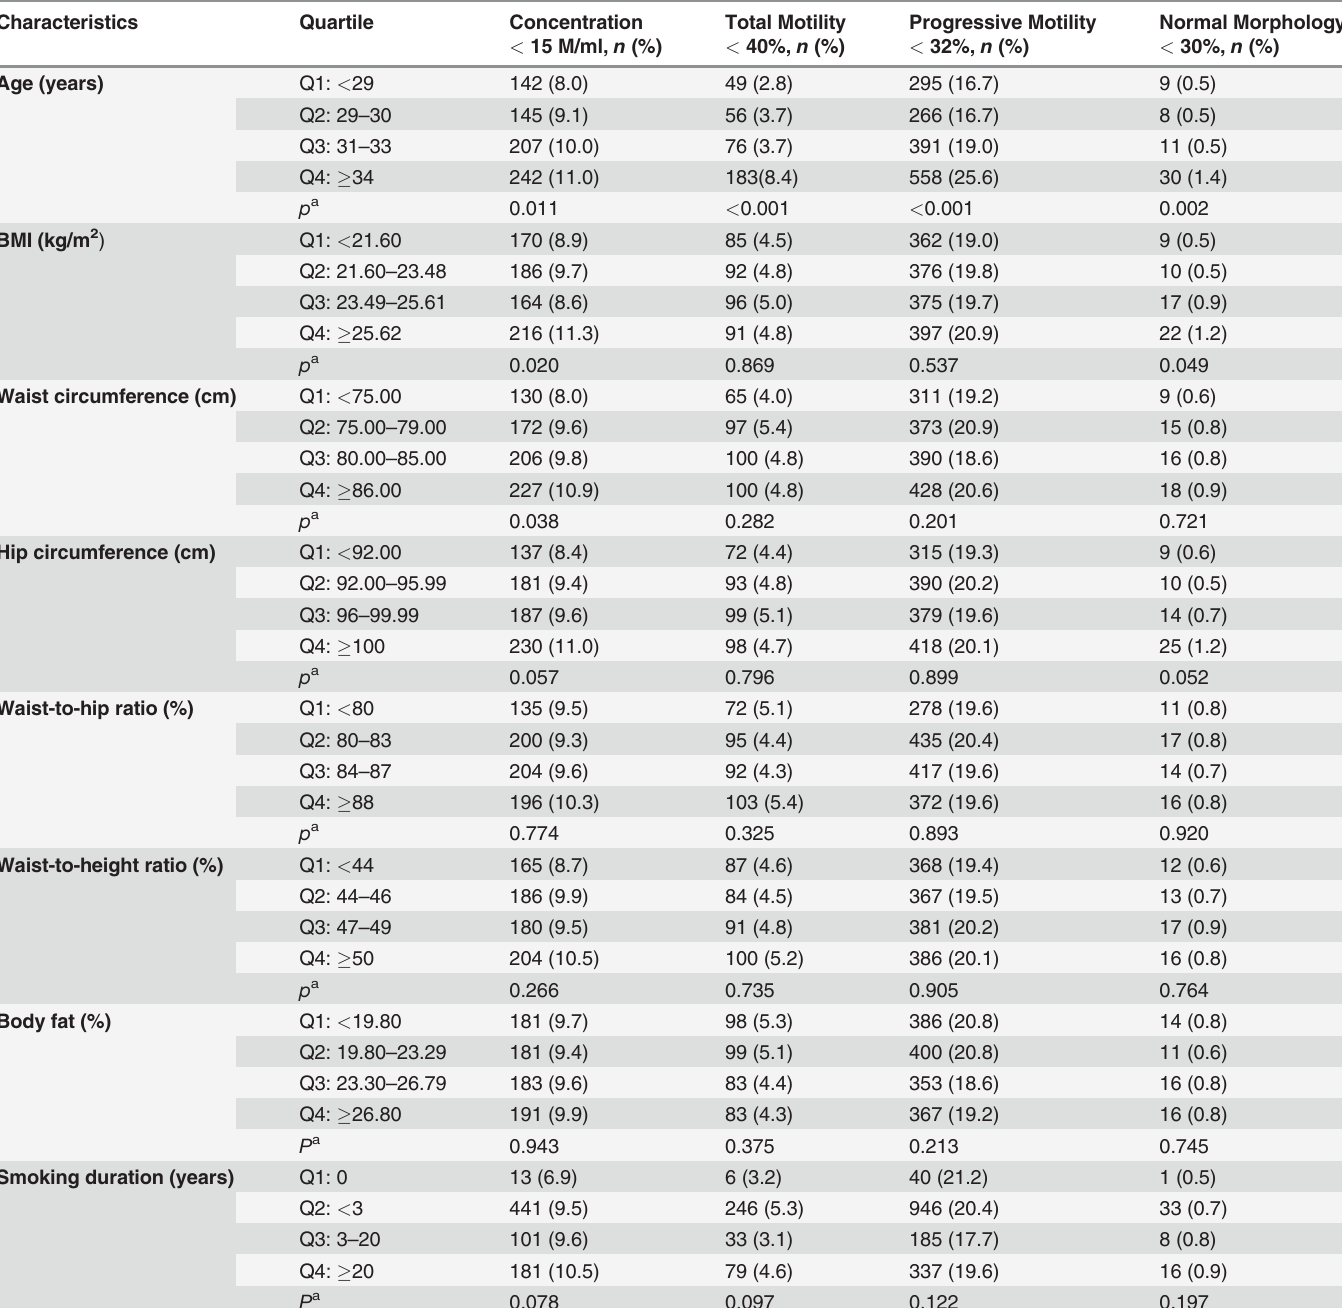
Table 3. The associations of abnormal semen quality with age and anthropometric indexes.